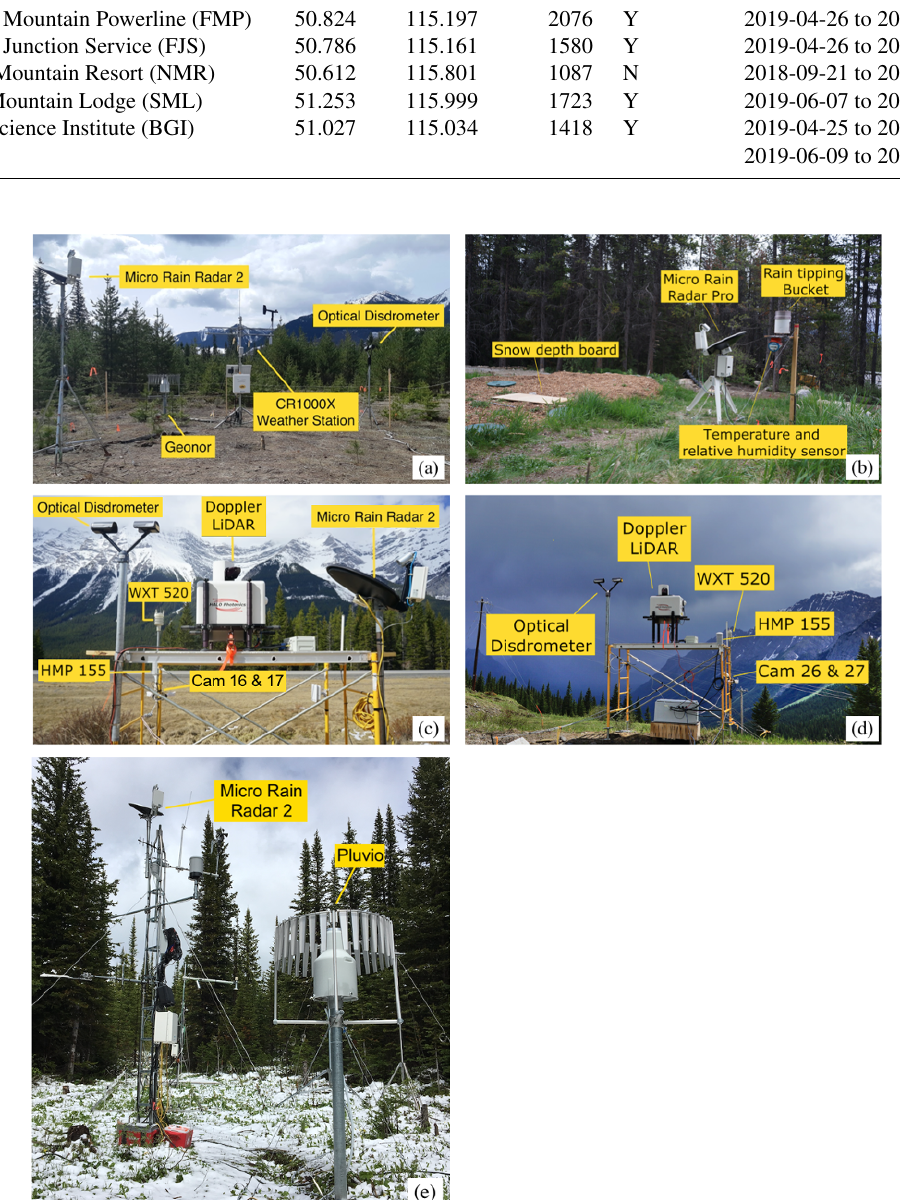
Figure 2. Instrumentation set-up at (a) Nipika Mountain Resort (NMR), (b) Storm Mountain Lodge (SML), (c) Fortress Junction Service (FJS), and (d, e) Fortress Mountain Powerline (FMP) with instruments labelled. See Fig. 1 for location of the field sites on a map. Note that not all instruments may be in the photos as some are located a short distance from the scaffolding. Only the instruments used are labelled. The Geonor at Nipika Mountain Resort is located approximately 10m from the weather station mast. A Pluvio was also used at FJS and was located approximately 7m from the other instruments on the scaffold. The instruments in panel (d) are located approximately 200m from the instruments in panel (e) . The Pluvio at FMP is located approximately 3m from the MRR-2 weather mast. A complete list of the instruments is given in Appendix